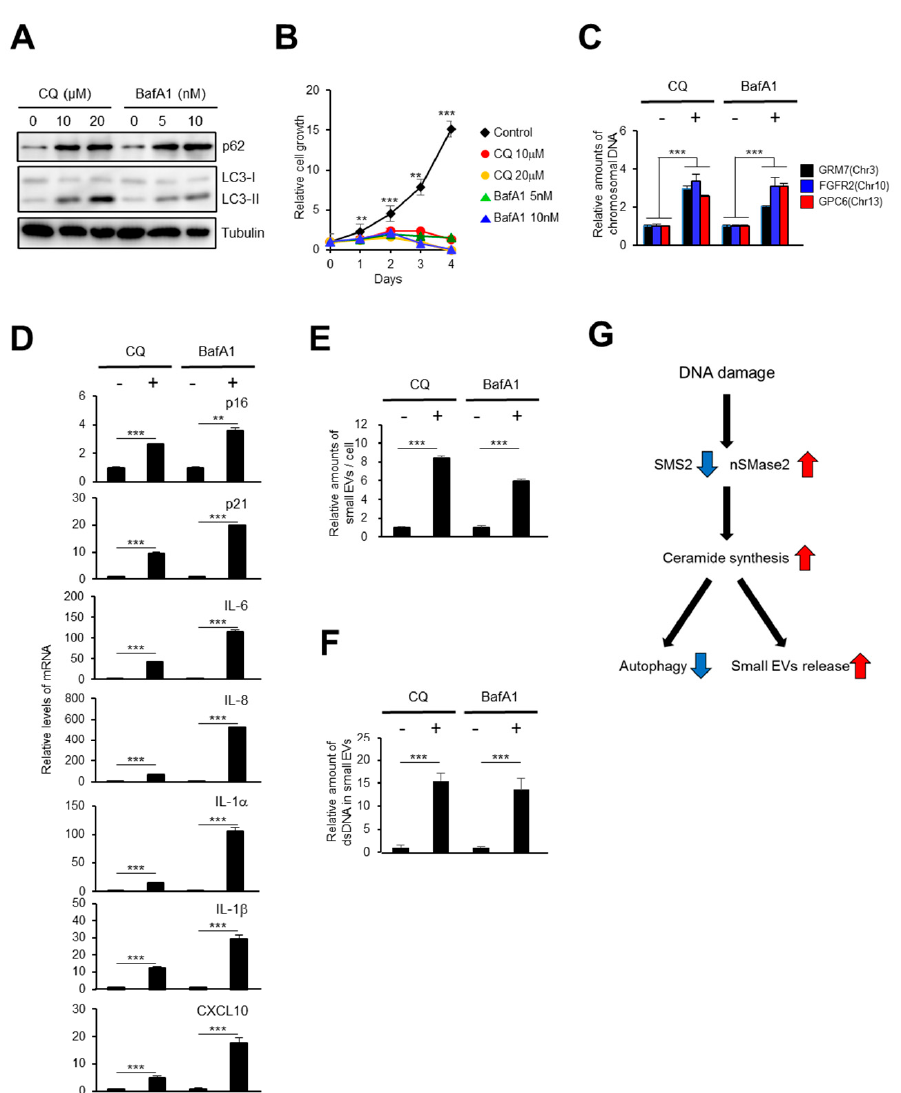
Figure 4. Inhibiting the autophagy pathway leads to the gene expression of SASP factors. ( A , B ) TIG-3 cells were treated with chloroquine (CQ) or bafilomycin A1 (BafA1) for 48 h and subjected to western blotting ( A ) and to cell proliferation analysis ( B ). ( C – F ) TIG-3 cells were treated with 20 µ M Chloroquine or 10 nM bafilomycin A1 for 48 h and subjected to isolation of cytoplasmic fraction followed by qPCR analysis of chromosomal DNA in cytoplasm ( C ), RT-qPCR analysis of SASP factor gene expression ( D ), NanoSight analysis of isolated small EV particles ( E ) or to quantitative analysis of dsDNA in small EVs ( F ). ( G ) A model of the molecular mechanism. DNA damage activates the ceramide synthetic pathway, both through SMS2 downregulation and nSMase2 upregulation, blocking autophagy and promoting the release of small EVs. For all graphs, error bars indicate mean ± standard deviation (s.d.) of triplicate measurements. p values was calculated by unpaired two-tailed Student’s t -test (** p < 0.01, *** p < 0.001).